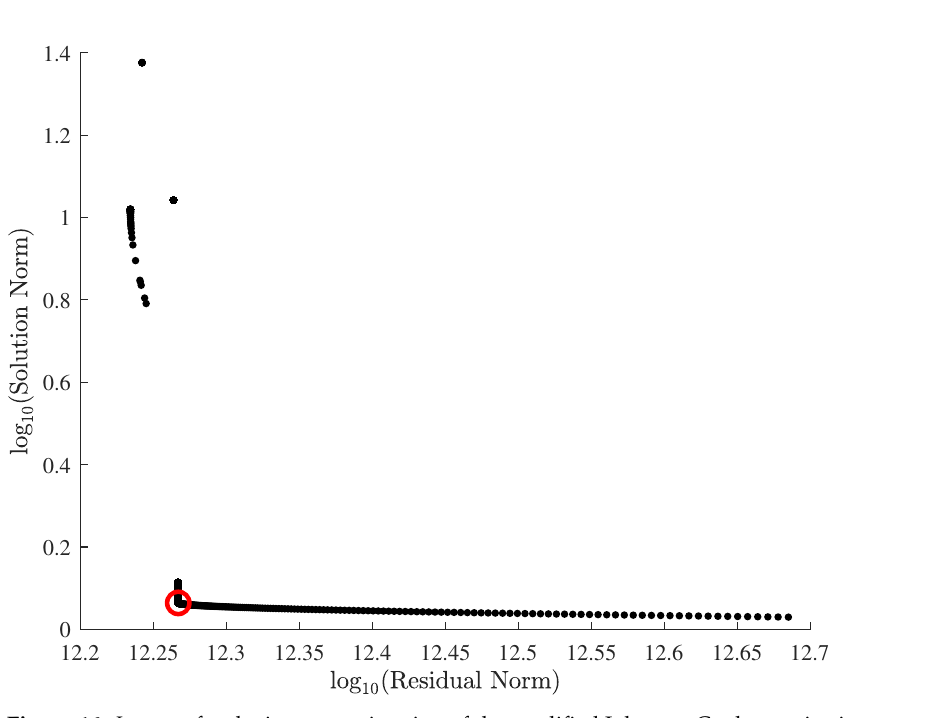
Figure 16. L -curve for the inverse estimation of the modified Johnson–Cook constitutive parameters.